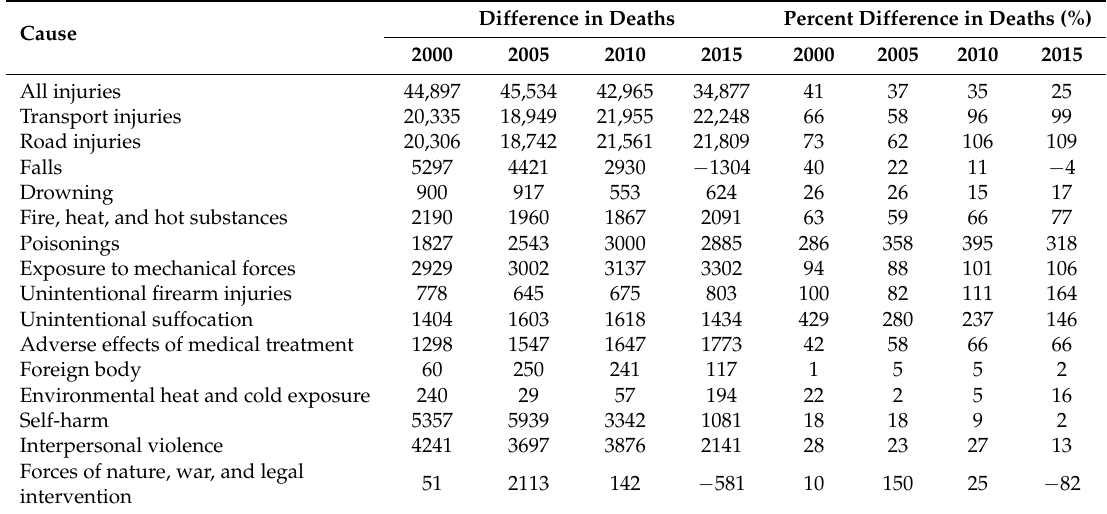
Table 2. Difference in injury deaths from the GBD 2015 and CDC WONDER (U.S., 2000–2015).